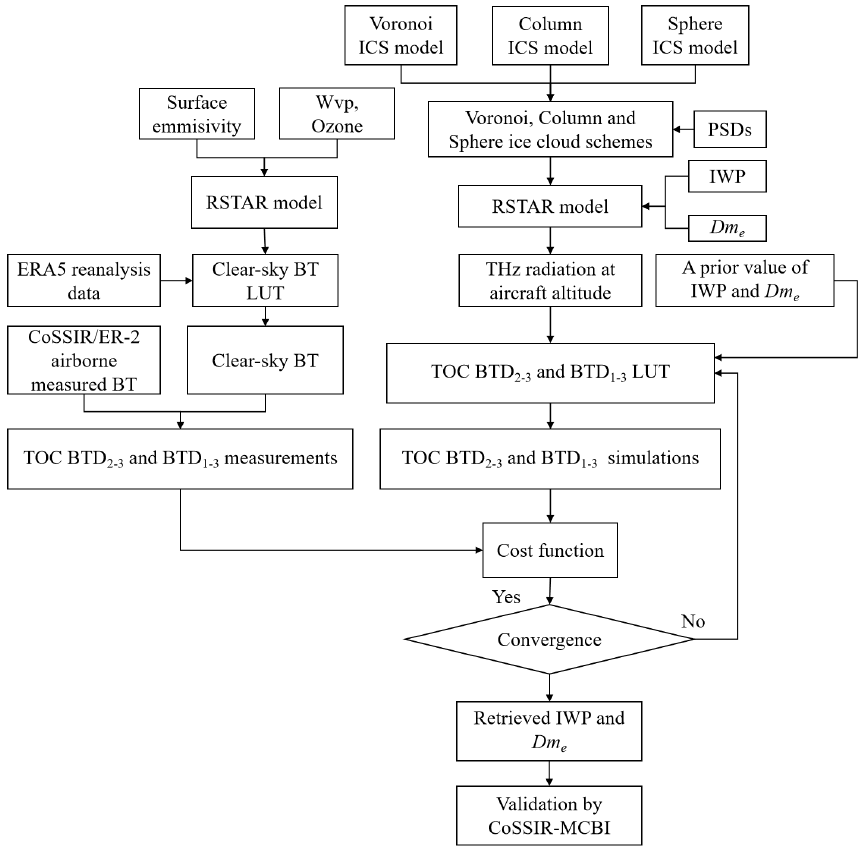
Figure 1. The overall flowchart of the retrieval of the IWP and D me of ice clouds based on the Voronoi, column, and sphere ICS models.